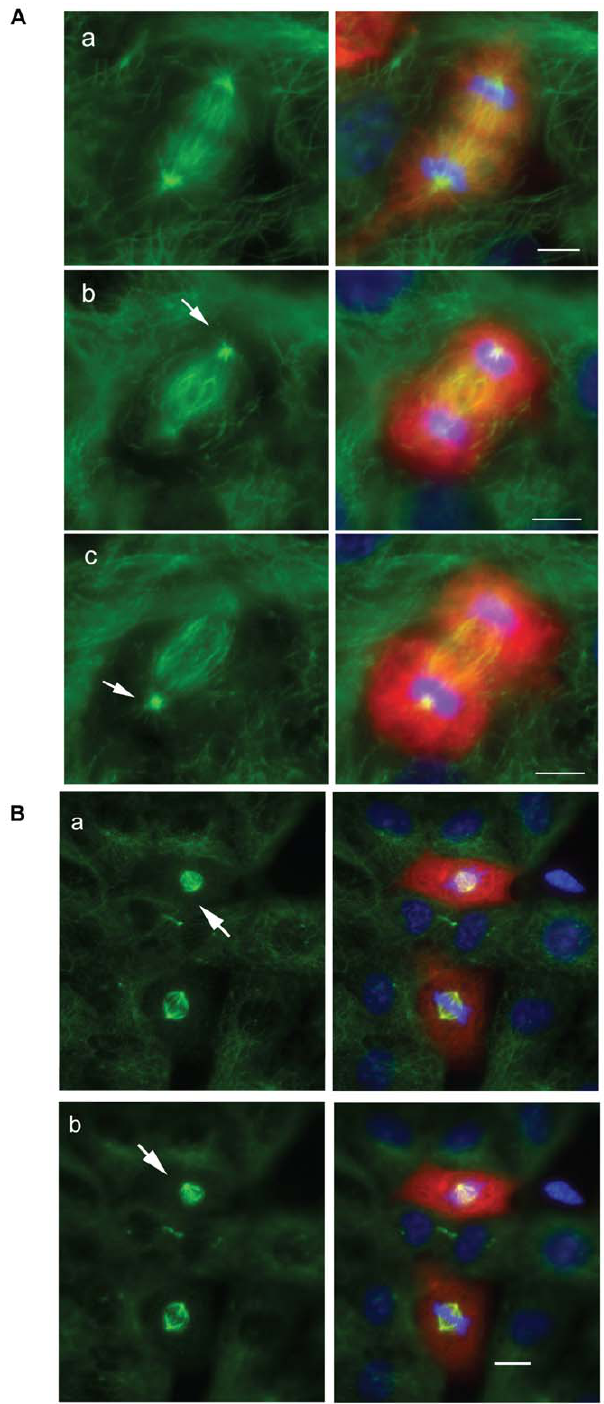
Figure 9. Microinjection of an anti-EB1 antibody induces tilted spindles. A. Immunostaining images of 4 U microinjected cells (a) and